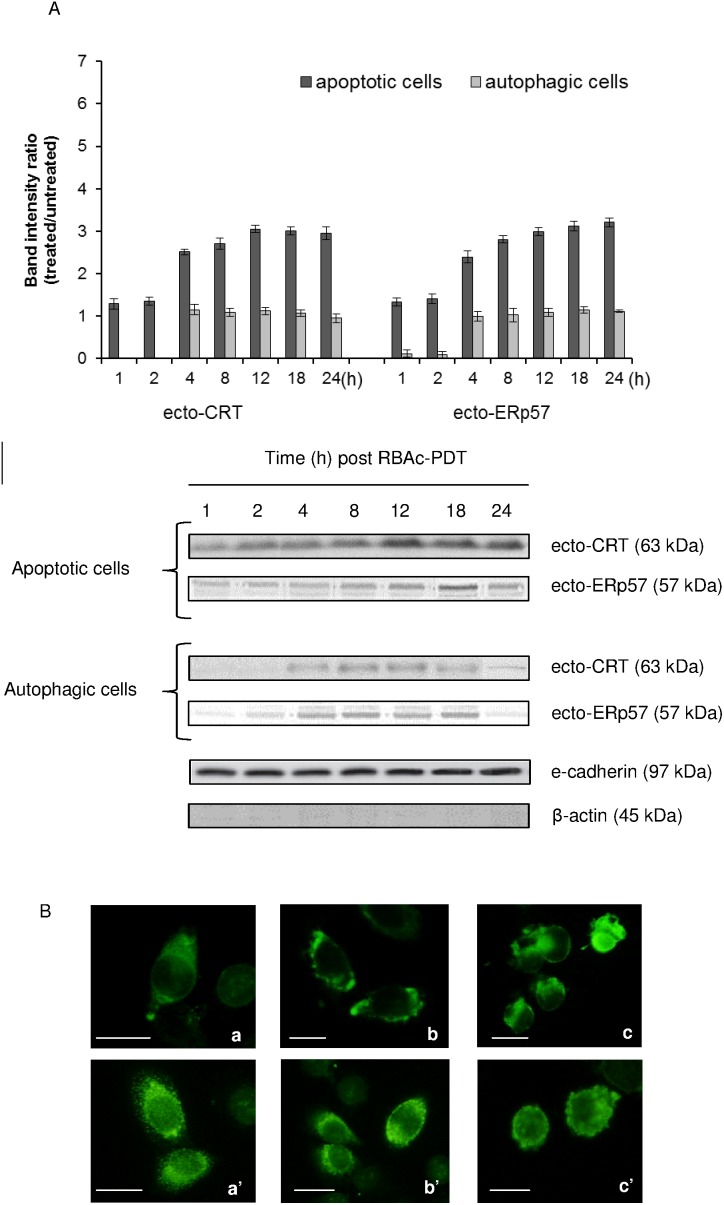
Surface exposure of CRT and ERp57 in RBAc-PDT-treated HeLa cells.
A. Kinetic of CRT and ERp57 membrane translocation (ecto-CRT and ecto-ERp57) was performed by Western blot of electroblotted to nitrocellulose membrane SDS-PAGE of membrane proteins fraction (30 µg protein/lane) of RBAc-PDT treated HeLa cells (10−5 M RBAc, 1 h, 1.6 J/cm2, 90 sec) in the presence of 3-MA (10 mM) and Nec-1 (300 µ) (apoptotic cells) and in the presence of z-VAD-FMK (20 µM) and 3-MA (10 mM) (autophagic cells) at indicated time intervals. Monoclonal antibodies against CRT (63 kDa) and ERp57 (57 kDa) were used. The amount of CRT and ERp57 proteins was reported as band intensity ratio (treated/untreated) measured by densitometer analysis. E-cadherin (97 kDa) and β-actin (45 kDa) expression is shown as control. Actin is absent in the membrane protein fraction. The data are the mean ± SD of three independent experiments. The values of the apoptotic cells are always significantly different (p<0.05) with respect to autophagic cells. The values of apoptotic cells values are significantly different (p<0.05) with respect to untreated cells for both ecto-CRT and ERp57. Unless the short times after PDT (2 h) whose values are significantly different (p<0.05) with respect to untreated cells, for all the other time points, the values of ecto-CRT and ecto-ERp57 of autophagic cells are not different from untreated cells. One representative Western Blot is shown out of the three independent experiments performed. B. Fluorescence micrographs of non permeabilized (a–c) and permeabilized (a’–c’) HeLa cells immunostained for CRT: viable (a, a’); 8 h (autophagic cells) (b, b’) and 12 h (apoptotic cells) (c, c’) of recovery after RBAc-PDT. Bar = 10 µm.